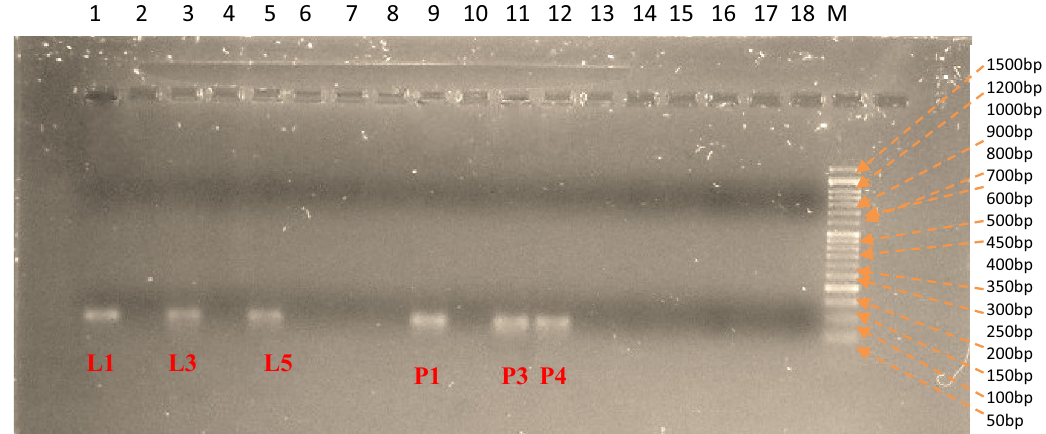
Figure 4. PCR amplicons of pqqA gene fragment. Lanes: 1, 3, 5, 9, 11 and 12 represent the amplification of pqqA gene from different PSB strains such as L1, L3, L5, P1, P3 and P4 respectively. Lanes: M denotes 50 bp DNA